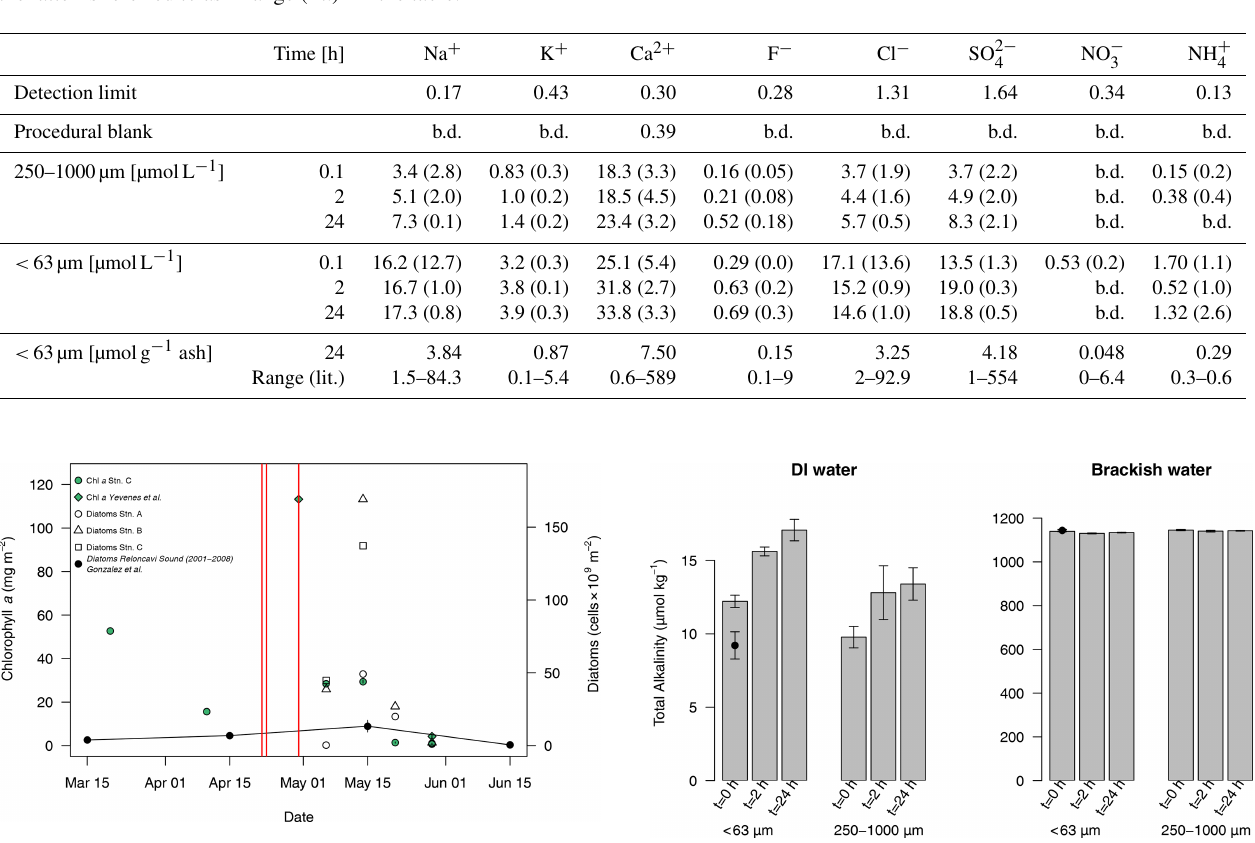
Figure 4. Changes in integrated (0–15m) diatom abundance and chlorophyll a for Reloncaví Fjord in April–May 2015. Locations are as per Fig. 1; the eruption dates are marked with red lines. Historical diatom data from Reloncaví Sound (2001–2008, integrated to 10m depth, mean ± standard error, González et al., 2010) and additional chlorophyll data from 2015 (“Station 3” from Yevenes et al., 2019, approximately corresponding to station C herein) are also shown.